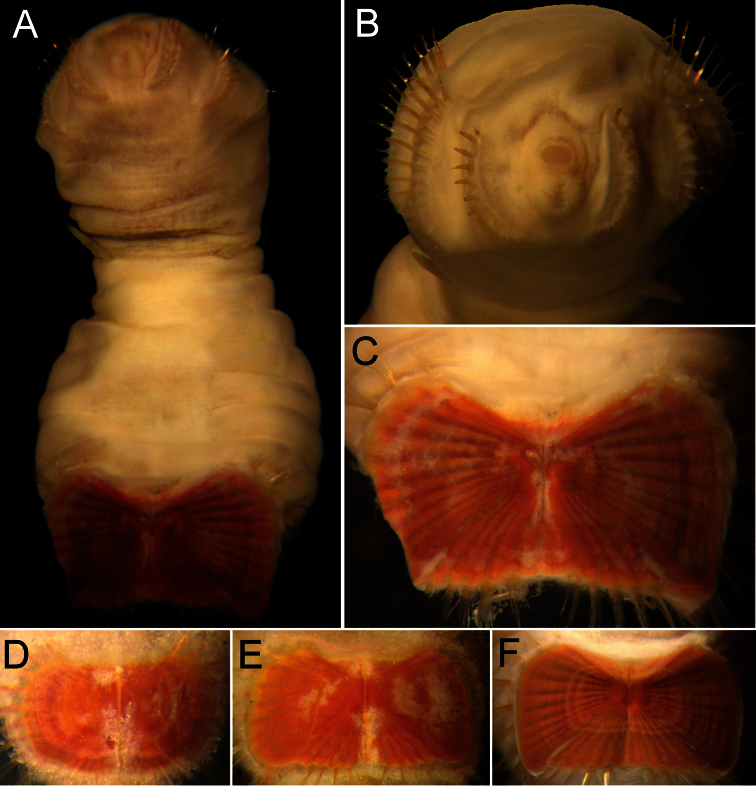
Sternaspis thorsoni sp. n. A Holotype (ZMUC 2221), ventral view B Same, anterior end, frontal view C Same, ventro-caudal shield D Mon type specimen (ZMUC Sta. 64), ventro-caudal shield E Paratype (ZMUC 2224), ventro-caudal shield F Another paratype (ZMUC 2223), ventro-caudal shield. Bars: A, F 0.8 mm B 0.6 mm C 0.5 mm D 0.3 mm E 0.4 mm.